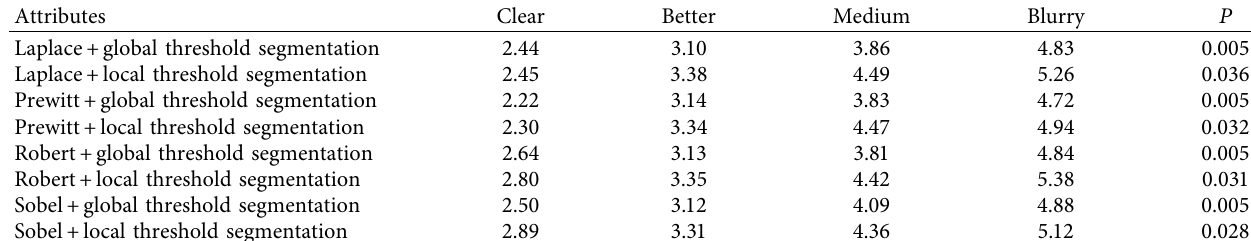
Table 3: Different threshold segmentation methods combined with edge detection processing data table.